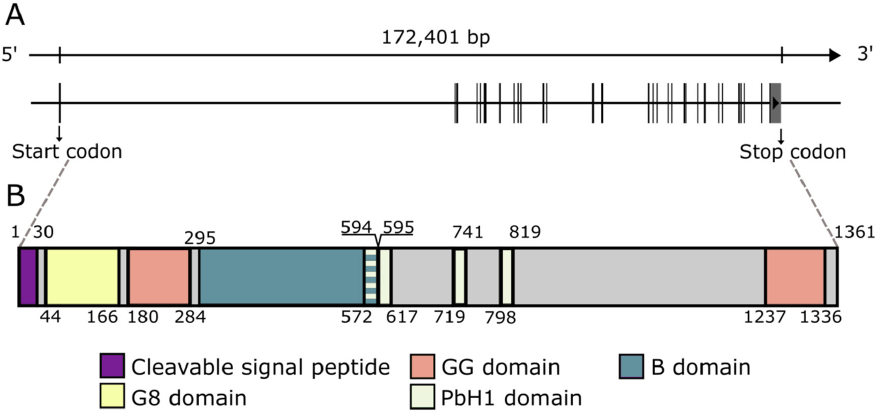
Figure 1. The genomic organization and protein domains of CEMIP. ( A ). The genomic organization of the 29 exons that comprise the CEMIP gene. ( B ). The major domains that comprise the CEMIP protein. The numbers refer to the amino acid positions that flank the different domains. The length and position of exons as well as domains are true to scale. The multi-domain protein CEMIP has emerged as a promiscuous interaction partner for an increasing number of proteins (Table 1). The domains of the CEMIP protein re- sponsible for these interactions have not always been investigated, but interestingly, binding partners have been described for all regions of the protein. This suggests that CEMIP acts as scaffold that is involved in the recruitment and organization of a range of other proteins. However, the direct functional molecular consequences of these interac- tions are incompletely understood. Some examples are given in the text below.